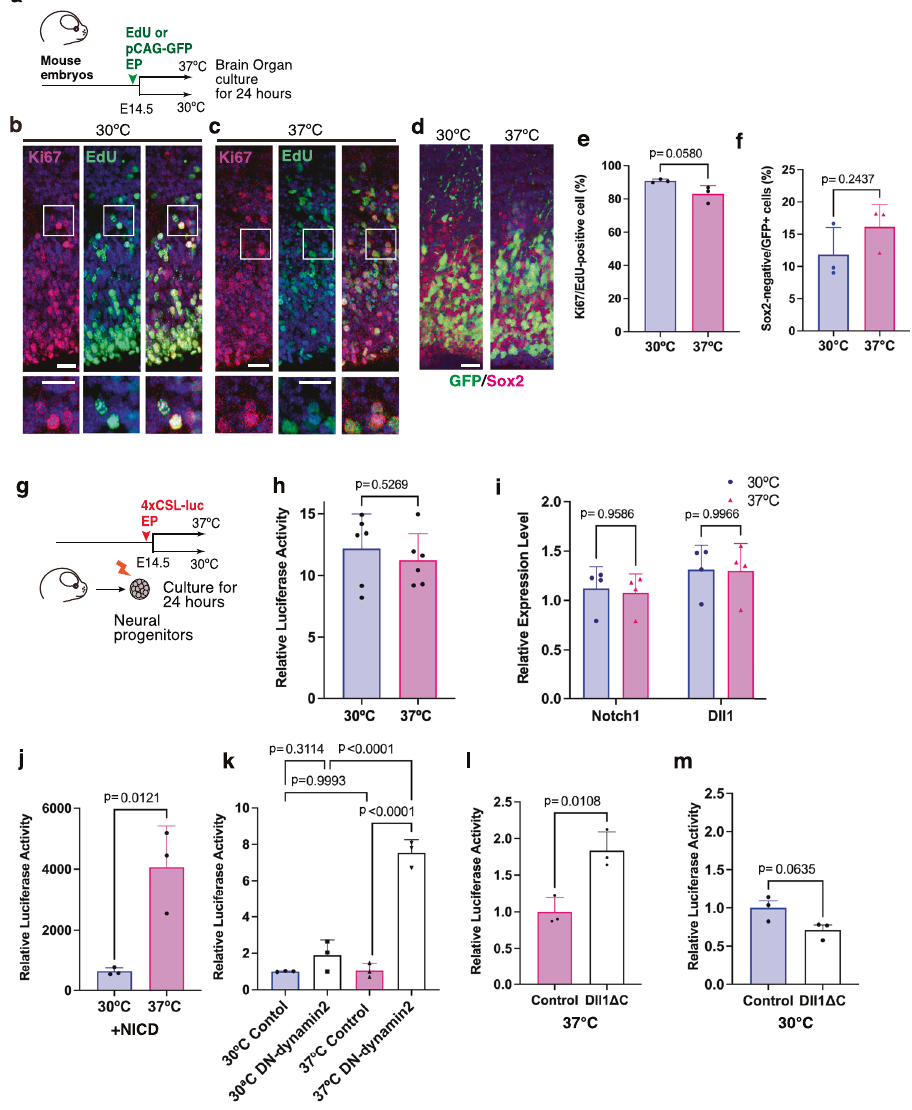
Fig. 5 Temperature robustness of Notch signaling in mouse neural progenitors. a Schematic illustration of the temperature shift experiment conducted on the developing mouse brain. b , c Distribution of Ki67-positive and/or EdU-positive cells in the developing mouse neocortex cultured at 30 °C ( b ) or 37 °C ( c ). d Distribution of GFP-positive cells in the developing mouse neocortex cultured at 30 °C or 37 °C. e , f The proportion of Ki67/EdU-positive cells ( e ) and Sox2-negative/GFP-positive cells ( f ) in the developing mouse neocortex cultured at 30 °C or 37 °C (mean + SD, n = 3 biologically independent samples in each group). g Monitoring of Notch activity in mouse neocortical neural progenitors cultured at 30 °C or 37 °C for 24 h. h Notch reporter activities in mouse neural progenitors cultured at 30 °C or 37 °C (means + SD, n = 6 biologically independent samples in each group). i Relative expression levels of genes encoding Notch1 and Dll1 in mouse neural progenitors cultured at 30 °C or 37 °C (means + SD, n = 4 biologically independent samples in each group). j NICD-dependent Notch reporter activities in mouse neural progenitors cultured at 30 °C or 37 °C (means + SD, n = 3 biologically independent samples in each group). k Notch reporter activities in control and dominant-negative dynamin 2 (DN-dynamin 2)-overexpressing neural progenitors cultured at 30 °C or 37 °C (means + SD, n = 3 biologically independent samples in each group). I , m Notch reporter activity in control neural progenitors and neural progenitors overexpressing Dll1 lacking intracellular domain (Dll1 Δ C) cultured at 37 °C or 30 °C (mean + SD, n = 3 biologically independent samples in each group). Two-sided, unpaired t -test ( e , f , h , j , l , m ), ordinary one-way or two-way ANOVA for k and i ( p -values were adjusted by Tukey or Sidak test for multiple comparisons). Scale bars: 20 µ